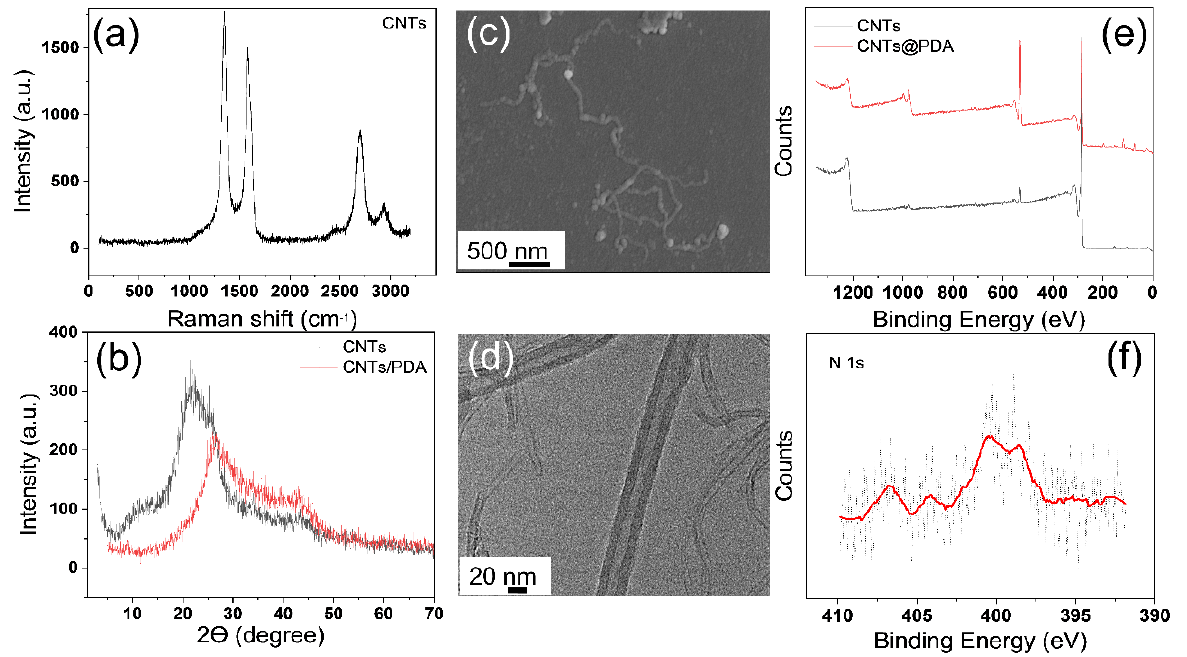
Figure 4. ( a ) The Raman spectrum of CNTs, ( b ) a comparison of XRD patterns of CNTs and CNTs@PDA, ( c ) SEM image of CNTs, ( d ) HRTEM image of CNTs@PDA, ( e ) a comparison of XPS spectra of CNTs and CNTs@PDA, ( f ) XPS spectrum of N1s of CNTs@PDA.